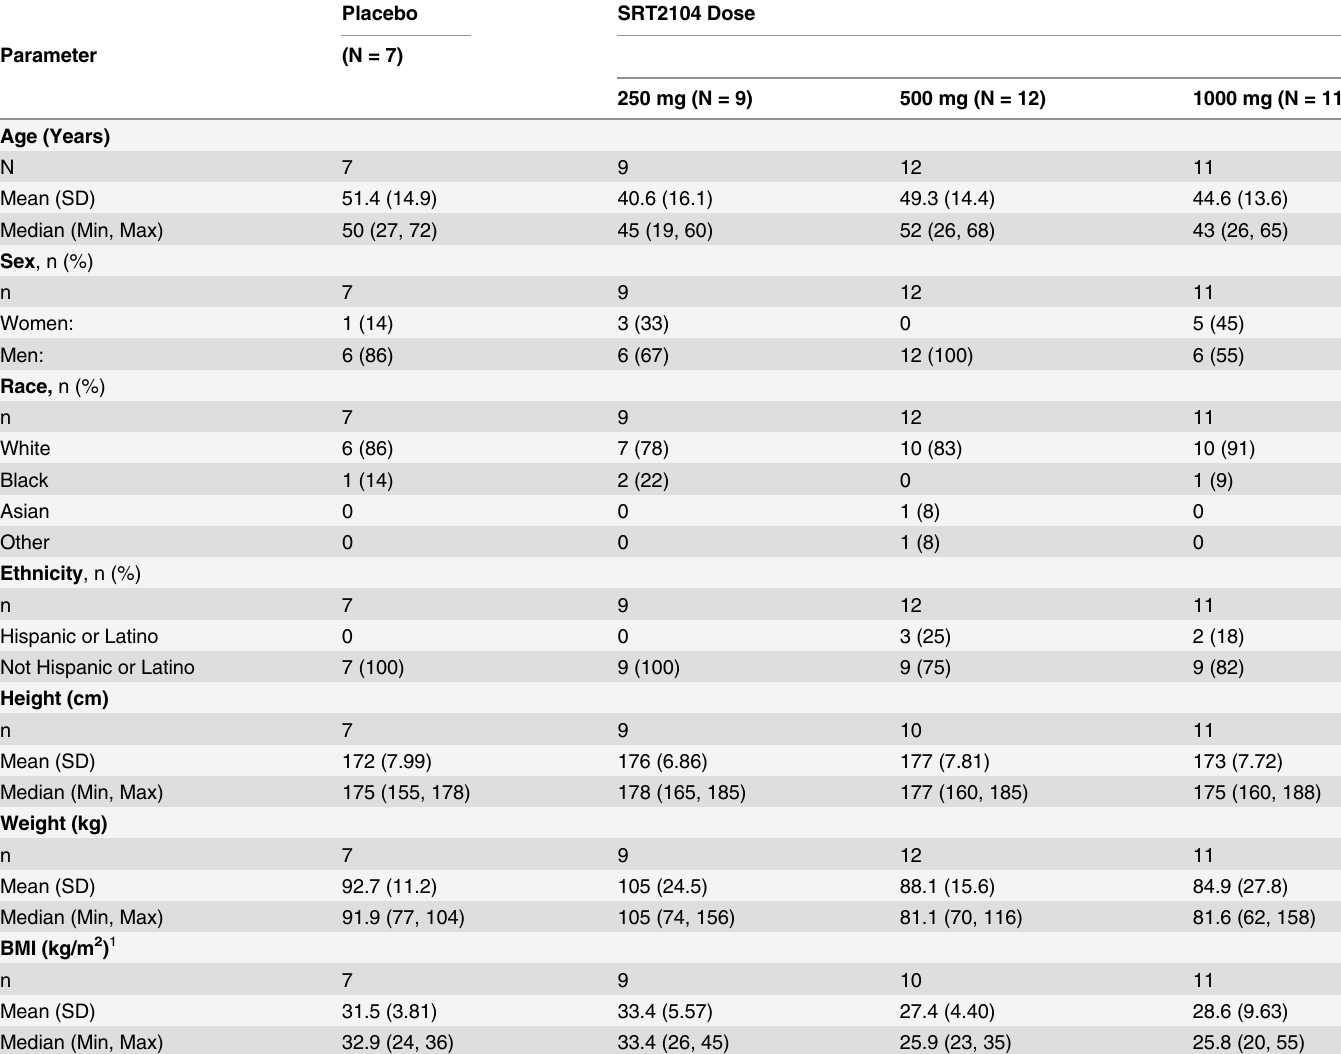
Table 1. Patient Demographics 1